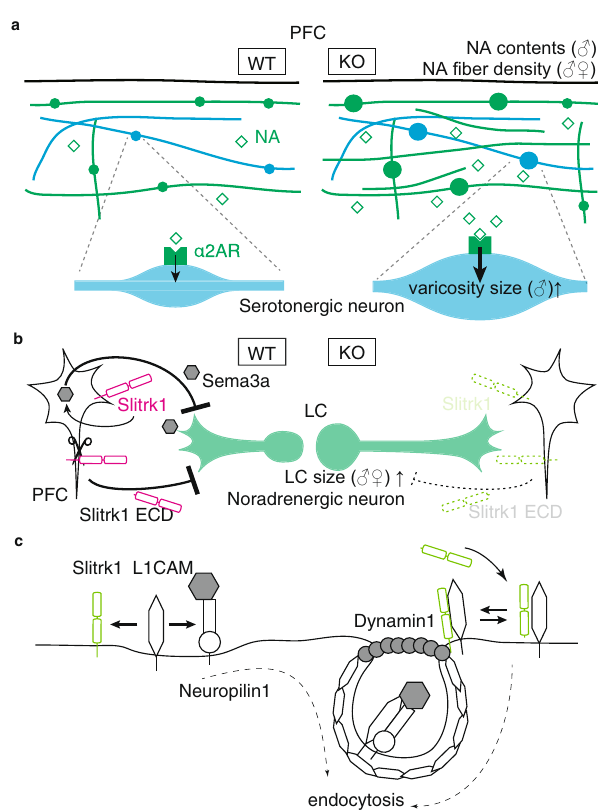
Fig. 10 Hypothetical mechanisms for Slitrk1-mediated control of monoaminergic fi ber development. The pictures indicate the mechanisms underlying the a occurrence of the Slitrk1-KO P7 brain phenotype, b Slitrk1- mediated noradrenergic fi ber suppression, and c Slitrk1-mediated endocytosis